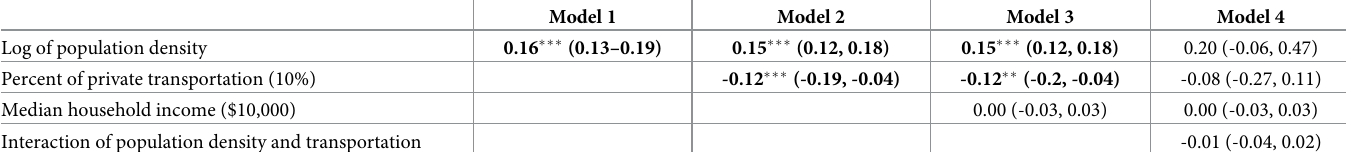
Table 1. Linear mixed models (random intercept, fixed slope) evaluating the association between population density and basic reproductive number (R 0 ) among United States counties.